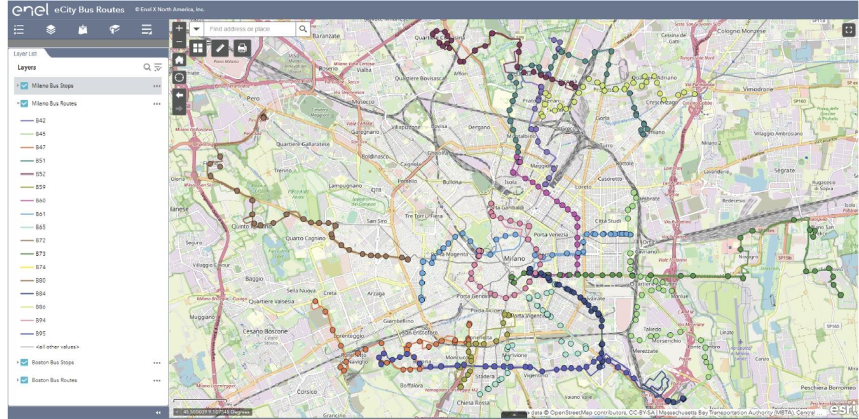
Figure 6: Route display for the Agenzia Mobilita Ambiente Territorio (AMAT) case.